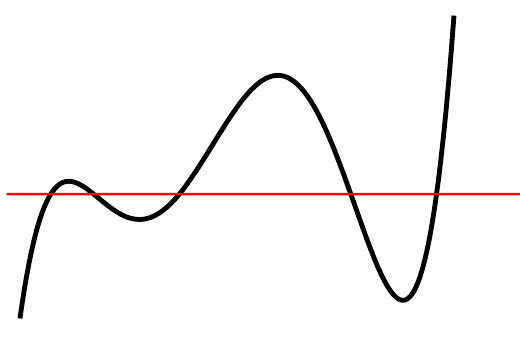
Figure 2 . The intersection number is 1 while the total number of roots are 5 . The horizontal red line is y = 0 , the gauge fixing line while the black curve is the function f . The gauge choice is f ( x ) = 0 which provides 5 roots. The contribution of them towards signed intersection number is 1